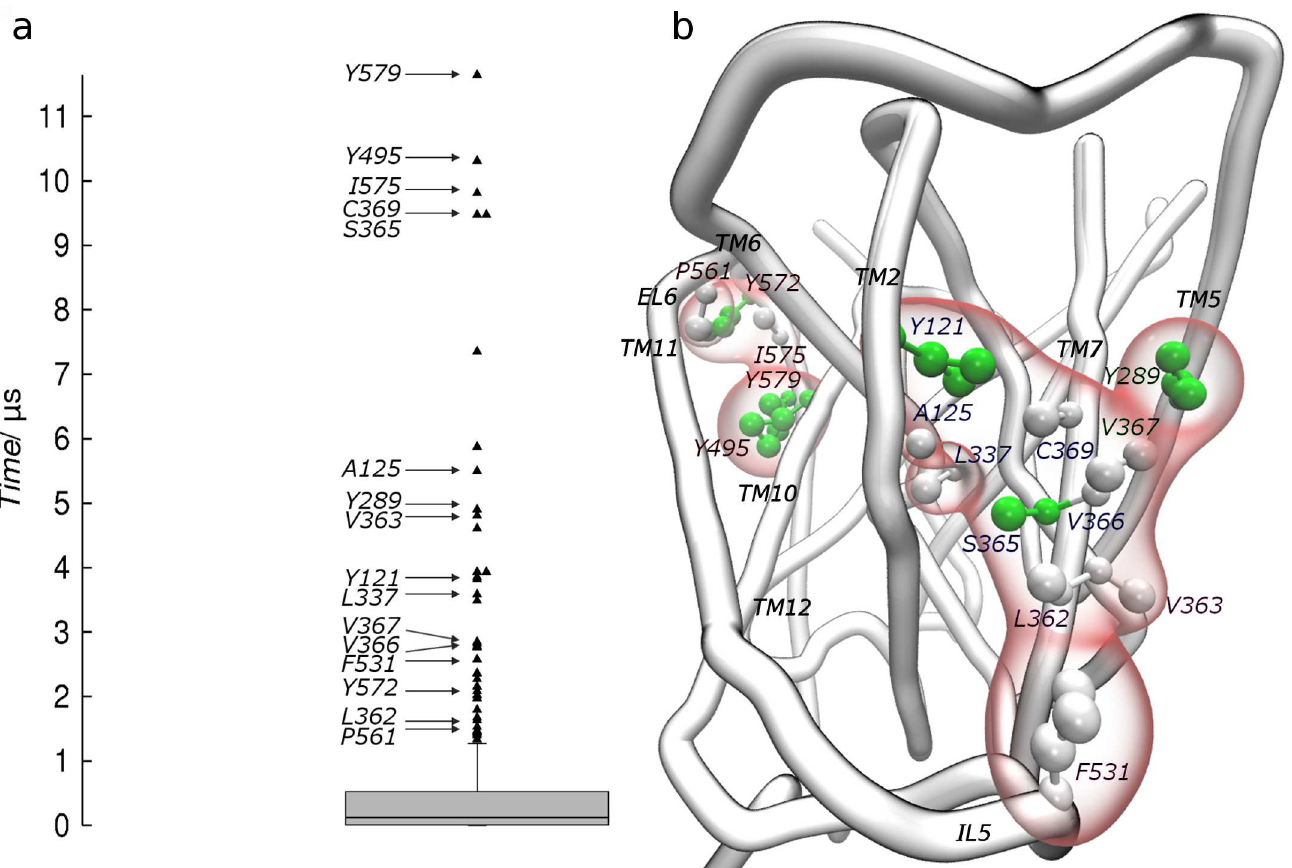
Fig 2. Outliers characterization. ( a ) Distributionof t max obtainedmerging elevendata-sets from SYS1-3 in a uniquepopulation.The box-plot diagram shows the outliers located above1.3 μ s (black triangles). ( b ) Corresponding amino acids are only labeledfor the sixteen outliers matchinga reproducible cholesterol density, and are mappedon the three-dimensional representation of the SERT surface. Outliers are colored by residue type and contoured by a red surface. Labels follow the site-basedcoloringscheme shownin Fig 3.